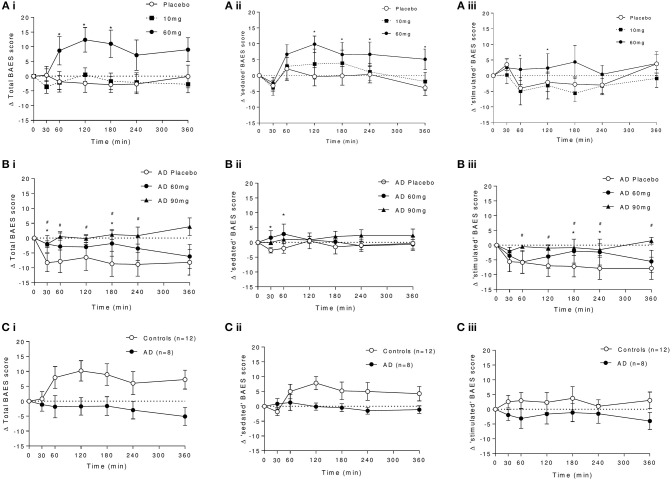
Effect of baclofen on (i) total, (ii) sedating, and (iii) stimulating components of the biphasic alcohol effects scale (BAES) in controls and AD. (A) Shows the dose response to placebo, 10 and 60 mg baclofen in controls. (B) Shows the dose response to placebo, 60 and 90 mg in AD. (C) Shows the group comparison at 60 mg baclofen (n = 12 controls and n = 8 AD) of (i) total, (ii) sedation, and (iii) stimulation components of the BAES. Data are mean ± S.E.M., *60 mg baclofen > placebo, #90 mg baclofen > placebo, (P < 0.05). Scale-items contributing to the sedation effects include “difficulty in concentrating,” “down,” “heavy head,” “inactive,” “sedated,” “slow thoughts,” and “sluggish.” Scale-items contributing to the stimulation effects include “elated,” “energized,” “excited” “stimulated” “talkative,” “up” and “vigorous.” Items are scored between 0 and 8.